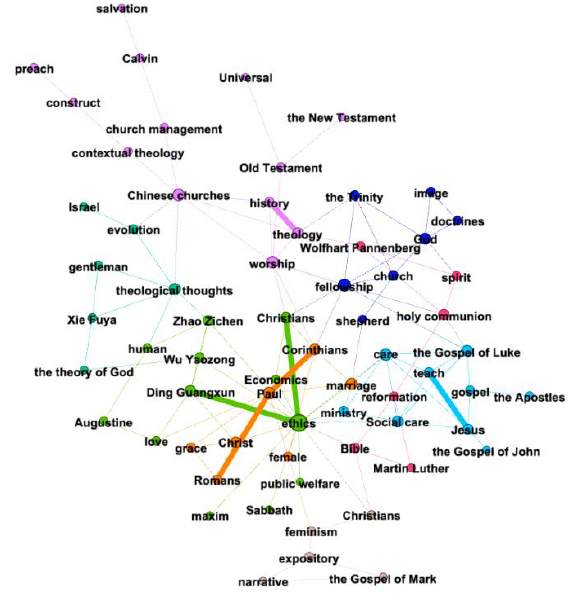
Figure 2. Keywords co-occurrence network.